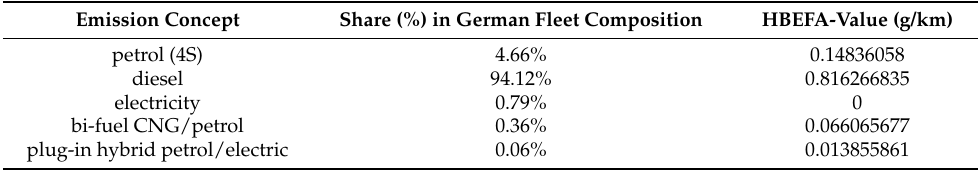
Table 2. Heavy-duty vehicle emission concepts and HBEFA emission